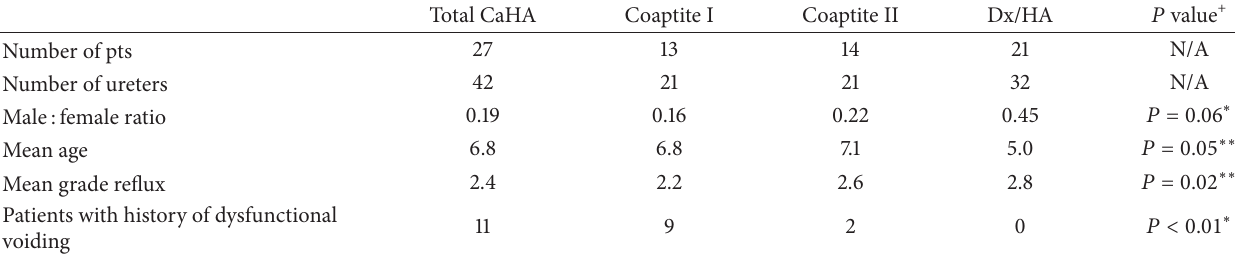
Table 1: Patient demographics.